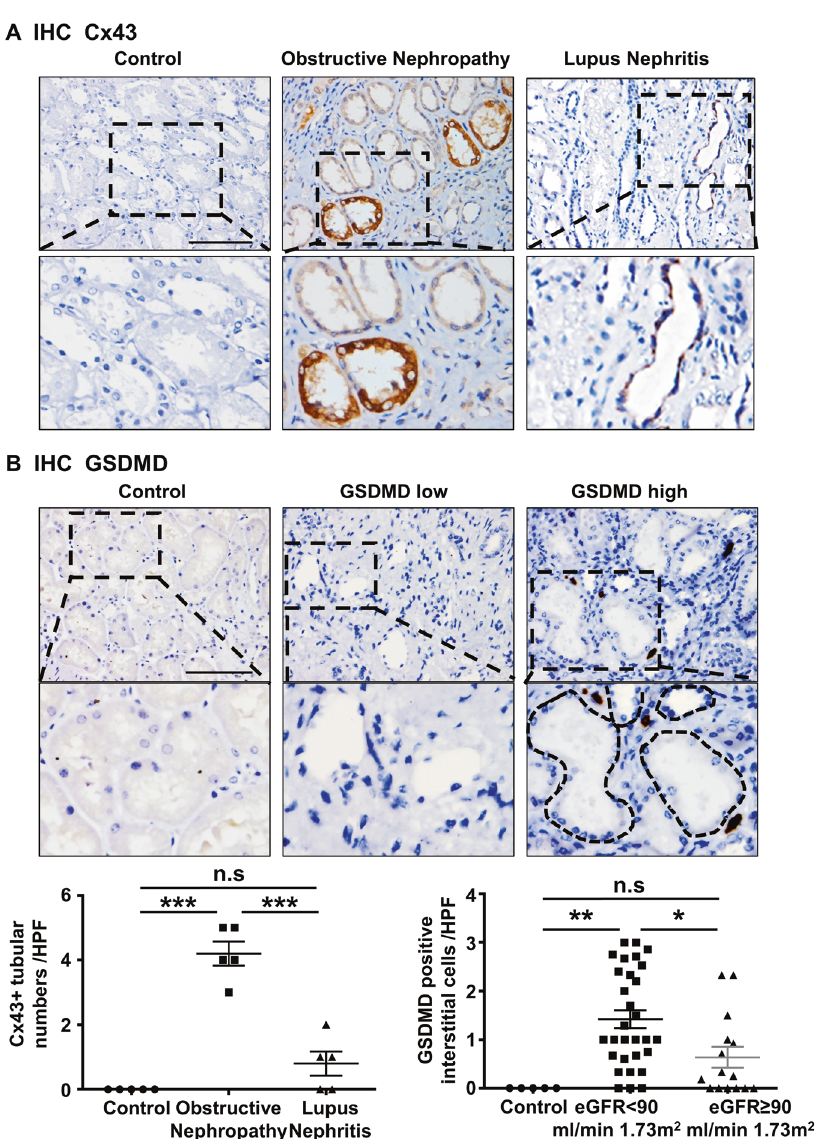
Fig. 7 The expression of Cx43 and GSDMD genes was associated with renal function in human obstructive nephropathy. A The representative image of Cx43 immunohistochemistry in TECs in human renal obstruction disease and lupus nephritis. B The representative image of GSDMD immunohistochemistry in GSDMD low group and GSDMD high group. Data are presented as the mean ± SEM, n.s. no signi fi cance, *** P < 0.001; Scale bar: 100 μ m. (Fig. 7A). GSDMD was observed to be expressed in renal interstitial The expression of Cx43 and GSDMD are associated with renal cells with obstructive nephropathy. Neither Cx43 nor GSDMD were function decline in human obstructive nephropathy found in normal kidney specimens. Further, we divided individuals We detected the expression of Cx43 and GSDMD in human kidney into two groups: those with an eGFR <90 ml/min/1.73 m 2 and diseases. Immunohistochemical staining showed greater expres- sion of tubular Cx43 in renal biopsy specimens from individuals those with an eGFR ≥ 90 ml/min/1.73 m 2 group. Peritubular diagnosed with obstructive nephropathy and lupus nephritis GSDMD high cell was de fi ned as the number of GSDMD-positive Cell Death and Disease (2022)